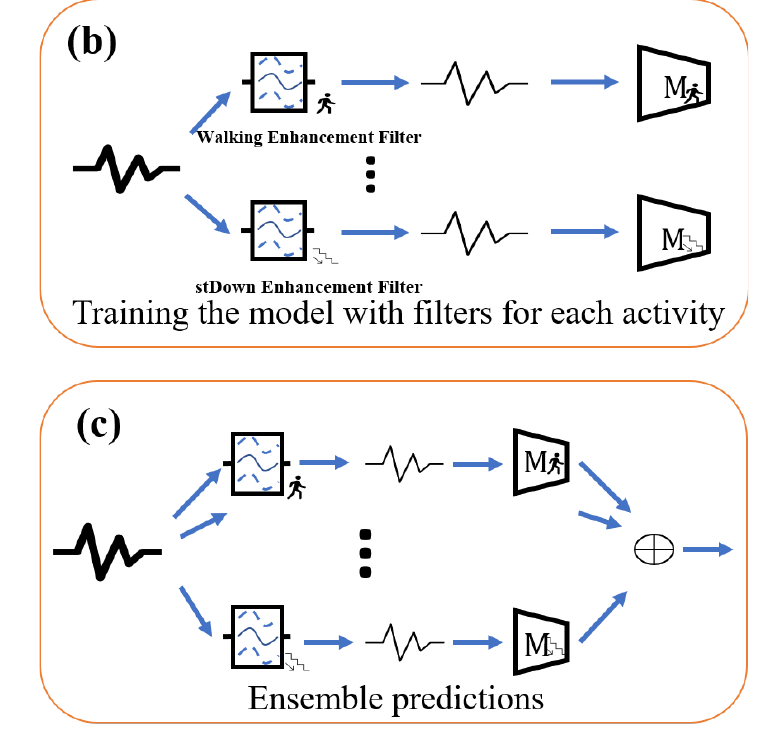
Figure 1. Overview of the proposed method. ( a ) Phase 1: Finding the important frequencies of each activity; ( b ) Phase 2: Emphasis during training; ( c ) Phase 3: Emphasis during testing.